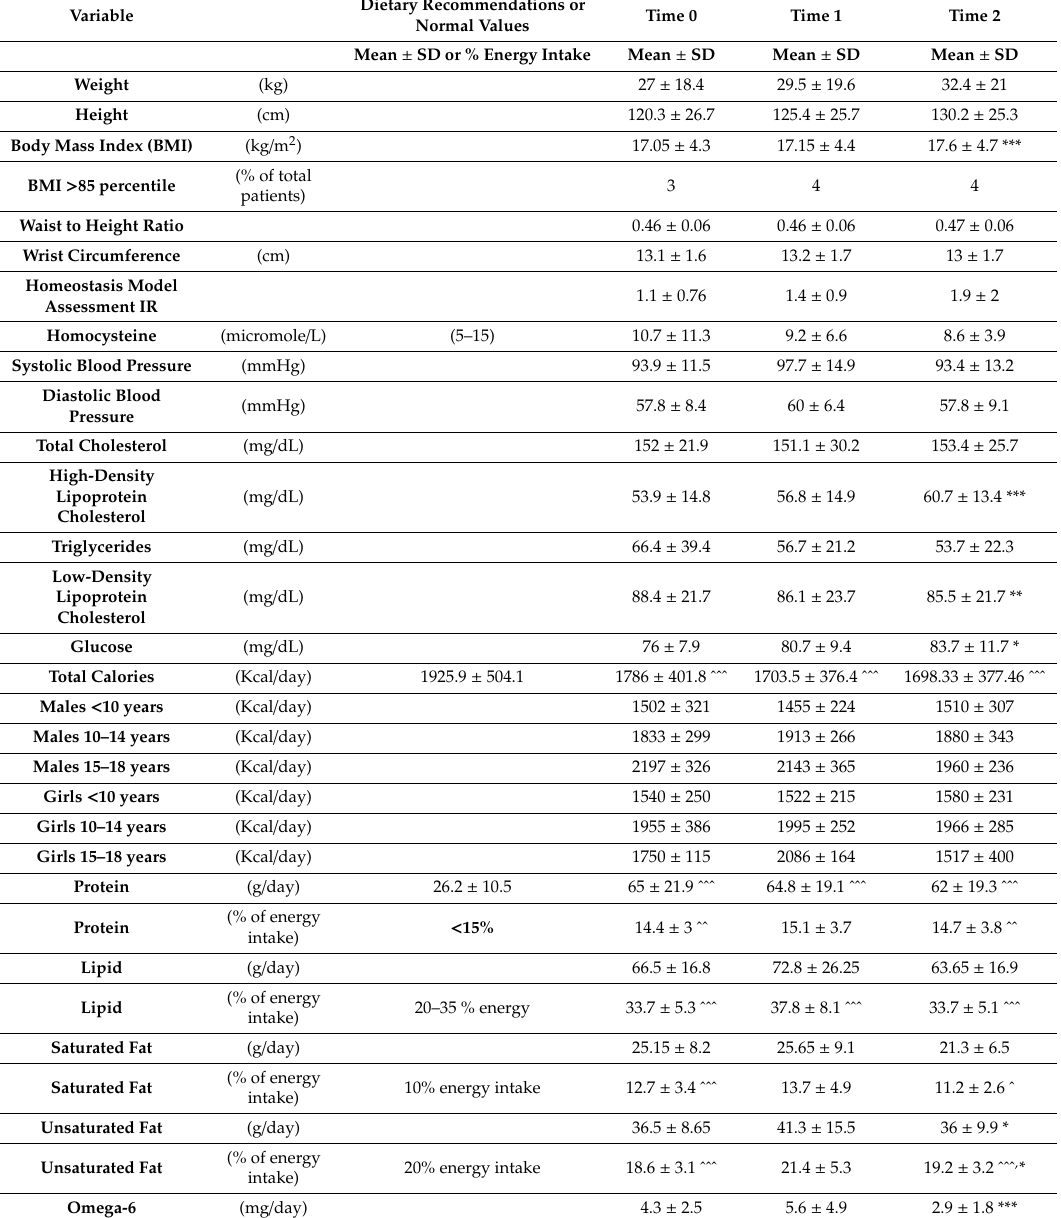
Table 1. Summary data pre and post gluten exclusion and comparison with